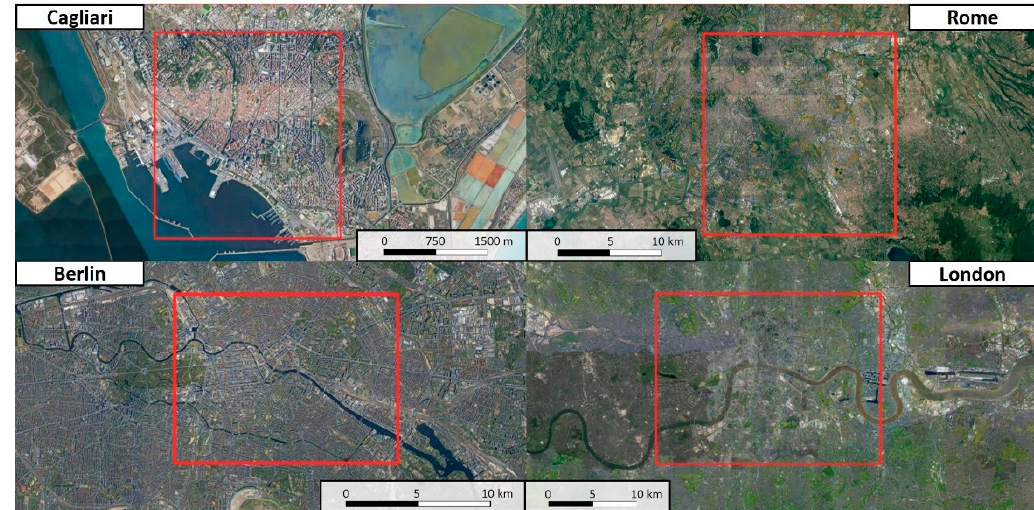
Figure 2. Geographical framing of case studies urban sites (source: Google Maps).